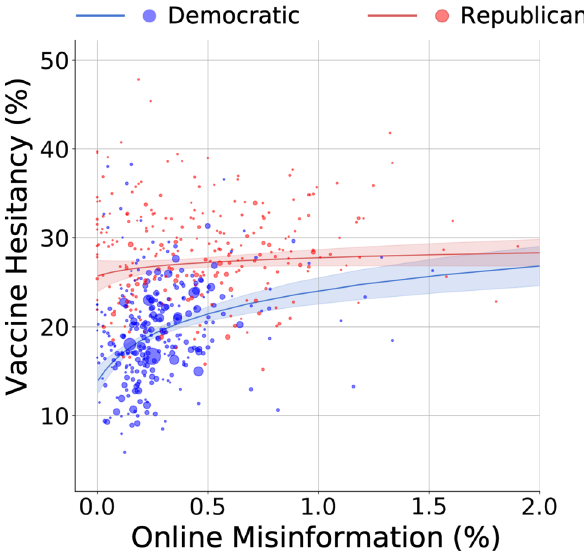
Figure 2. Associations of online misinformation and political partisanship with vaccination hesitancy at the U.S. county level. Each dot represents a U.S. county, with size and color indicating population size and political majority, respectively. The average proportion of misinformation shared on Twitter by geolocated users was fitted on a log scale due to non-normality (i.e., positive skew) at the county level. The two lines show predicted values of vaccine hesitancy as a function of misinformation for majority Democratic and Republican counties, adjusting for county-level confounding factors (see Methods). Shaded area corresponds to 95%